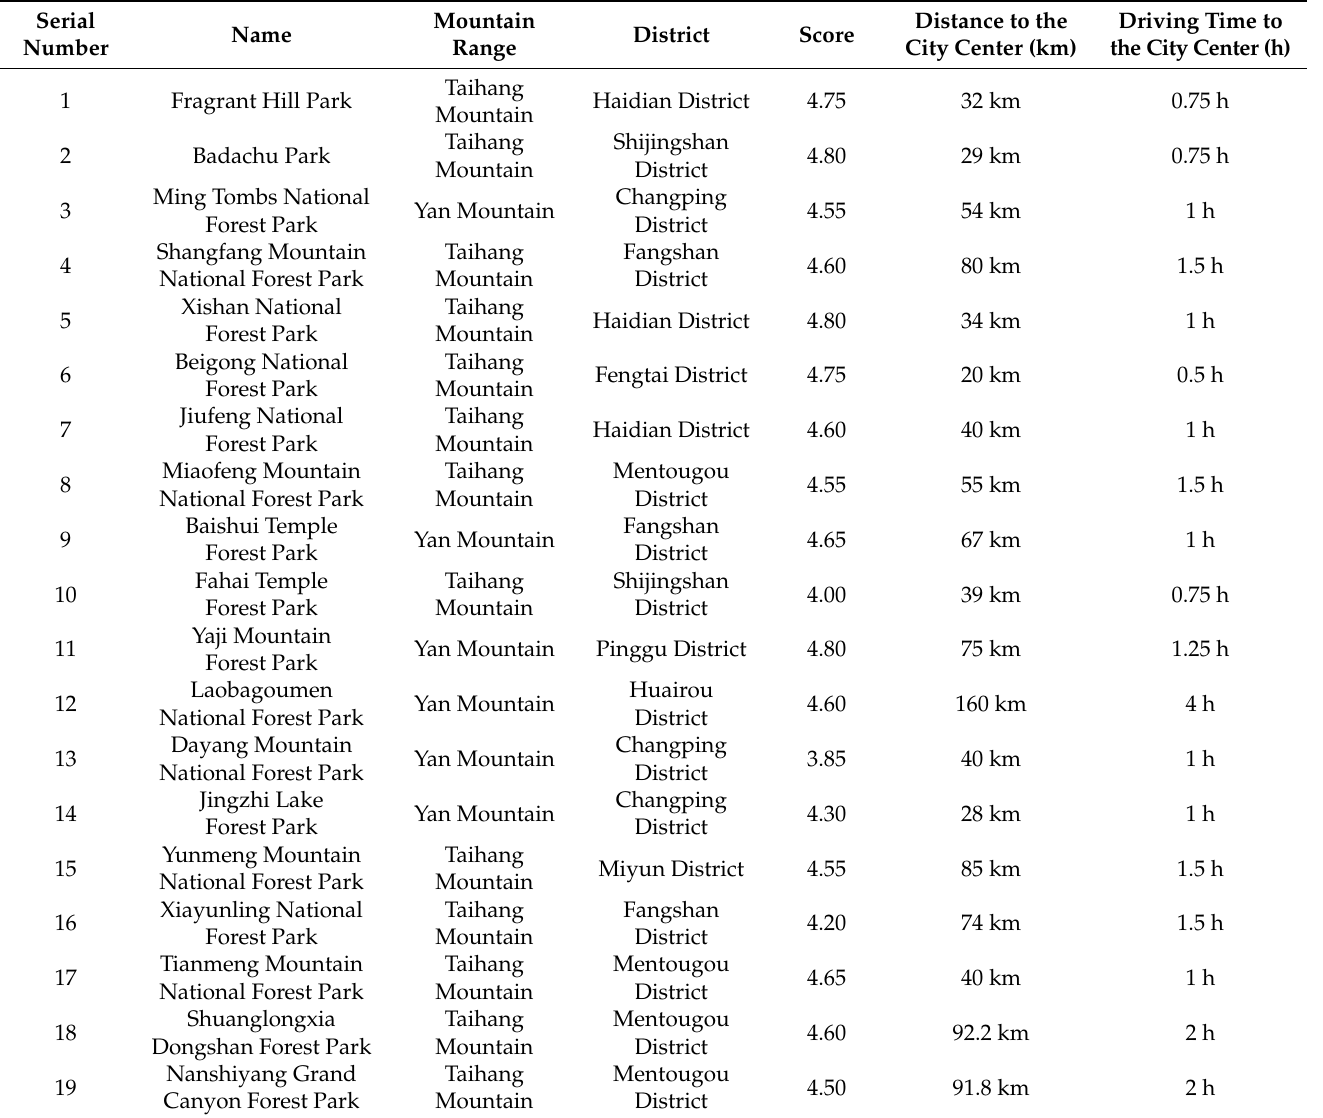
Table 1. Basic information on mountain